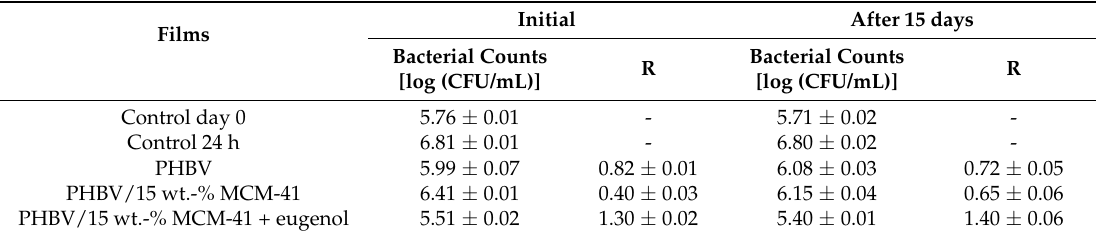
Table 7. Antibacterial activity against Escherichia coli ( E. coli ) in the open system for the electrospun films of poly(3-hydroxybutyrate- co -3-hydroxyvalerate) (PHBV) and PHBV/Mobil Composition of Matter (MCM)-41 with eugenol.